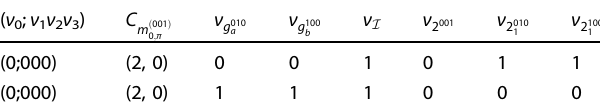
Table 1. The two possible topological states with SIs Z 2 ; 2 ; 2 ; 4 ¼ ð 0 ; 0 ; 0 ; 2 Þ and mirror Chern number C ¼ ð 2 ; 0 Þ in SG Pbam (No. m ð 001 Þ 0 ; π , are the mirror Chern numbers for the 55) 41 . The Z invariants, C m ð 001 Þ 0 ; π mirror planes M ð 001 Þ with k z = 0, π , respectively. All the listed ν ’ s are Z 2 classi fi ed topological invariants. The set ( ν 0 ; ν 1 ν 2 ν 3 ) are the invariants for 3D Z 2 TIs. ν g 010 and ν g 100 represent the invariants for the glide a b symmetries G y and G x , respectively. ν I is the inversion I protected TCI index, where ν I ¼ 1 , features the hinge states in a 3D fi nite geometry preserving I . ν 2 001 , ν 2 010 and ν 2 100 denote the invariants for the 1 1 and 2 ½ 100 (cid:2) , rotational and screw symmetries 2 [001] , 2 ½ 010 (cid:2) 1 1